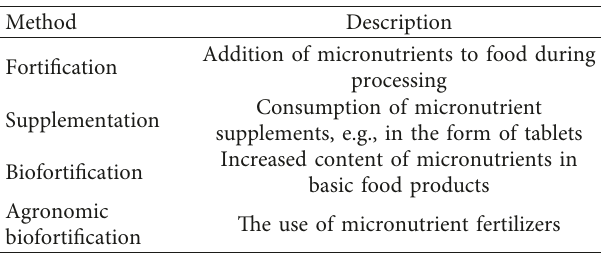
Table 1: The methods used to increase the intake of micronutrients